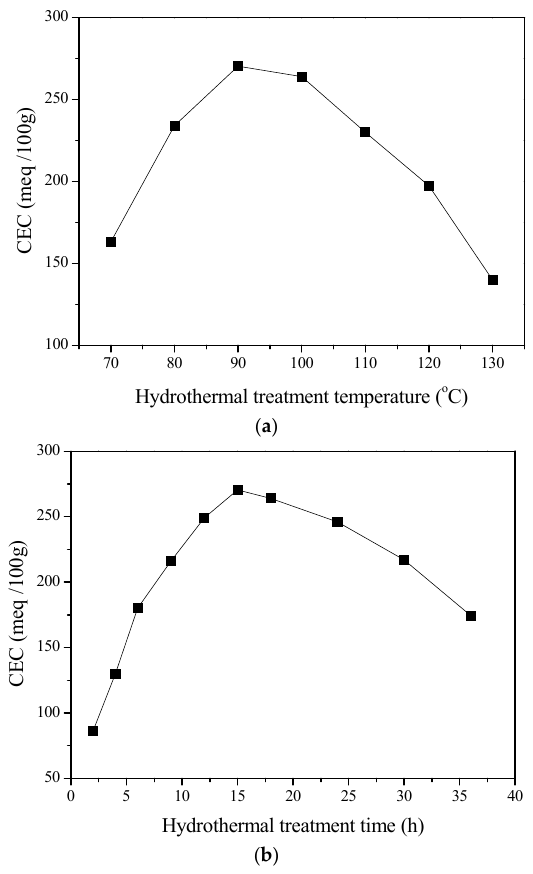
Figure 4. Effect of hydrothermal treatment conditions on the CEC of synthesized zeolite (NaOH/coal fly ash ratio 1.2 g/g, liquid/solid ratio 5 mL/g, 1.5 h alkali fusion under 550 °C). ( a ) Hydrothermal treatment temperature; ( b ) Hydrothermal treatment